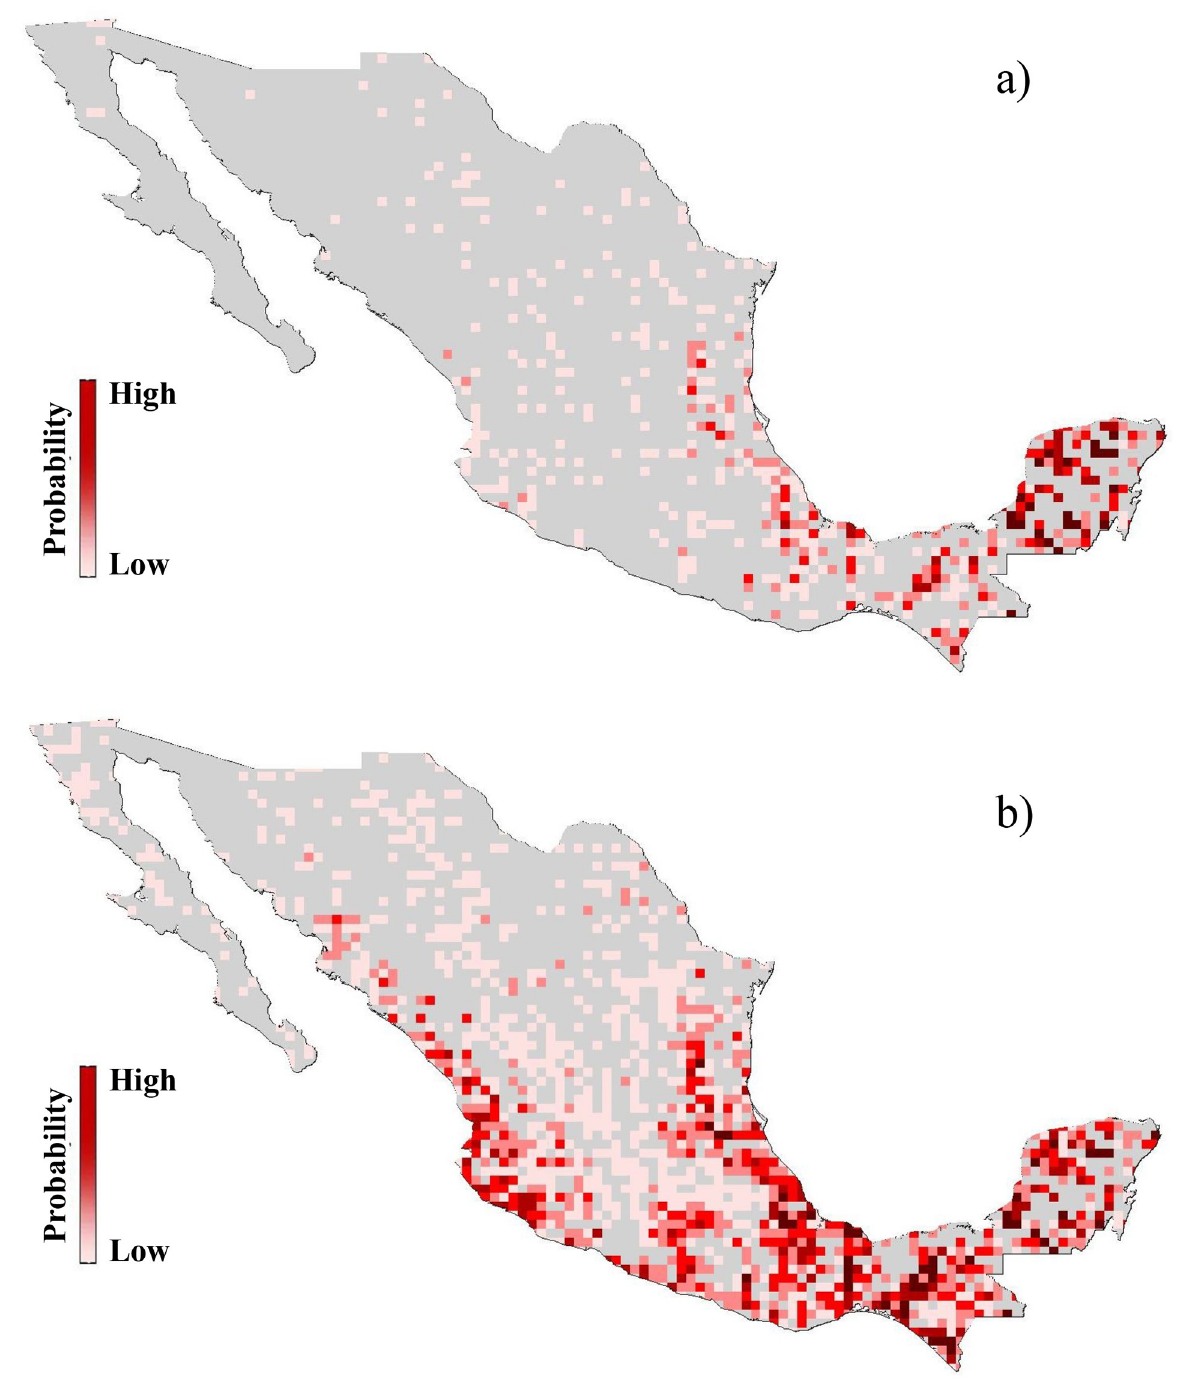
Fig 5. Risk maps of Leishmaniasis: a) determined by using only the 8 previously confirmed hosts, b) determined by using the 22 new confirmed hosts and previously confirmed hosts of L . ( L .) mexicana .